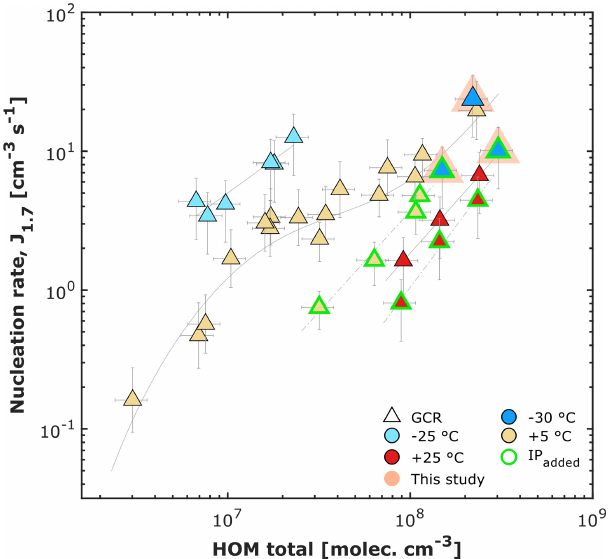
Figure 8. Pure biogenic nucleation rates at 1.7nm diameter against total HOM concentration at different temperatures for α -pinene and α -pinene + isoprene systems. The HOM total is defined as the sum of C 5 , C 10 , C 15 , and C 20 carbon classes. Triangles represent galac- tic cosmic ray (GCR) conditions. Data points at + 5 and + 25 ◦ C are from Kirkby et al. (2016) and Heinritzi et al. (2020). Data points at − 25 ◦ C are from Simon et al. (2020). The value of isoprene-to- monoterpene carbon ratio ( R ) varies from 1.5 to 6.5 for Heinritzi et al. (2020), and R is equal to 14.4 and 6.1 for this study. The points with orange marker on the background indicate the contribution of this work. Solid lines represent power-law fits to GCR conditions of the systems with α -pinene only, and dashed lines are the power-law fits of the systems with isoprene added. Bars indicate 1 σ run-to-run experimental uncertainty. The overall systematic-scale uncertainty of HOMs of + 78% and − 68% is not